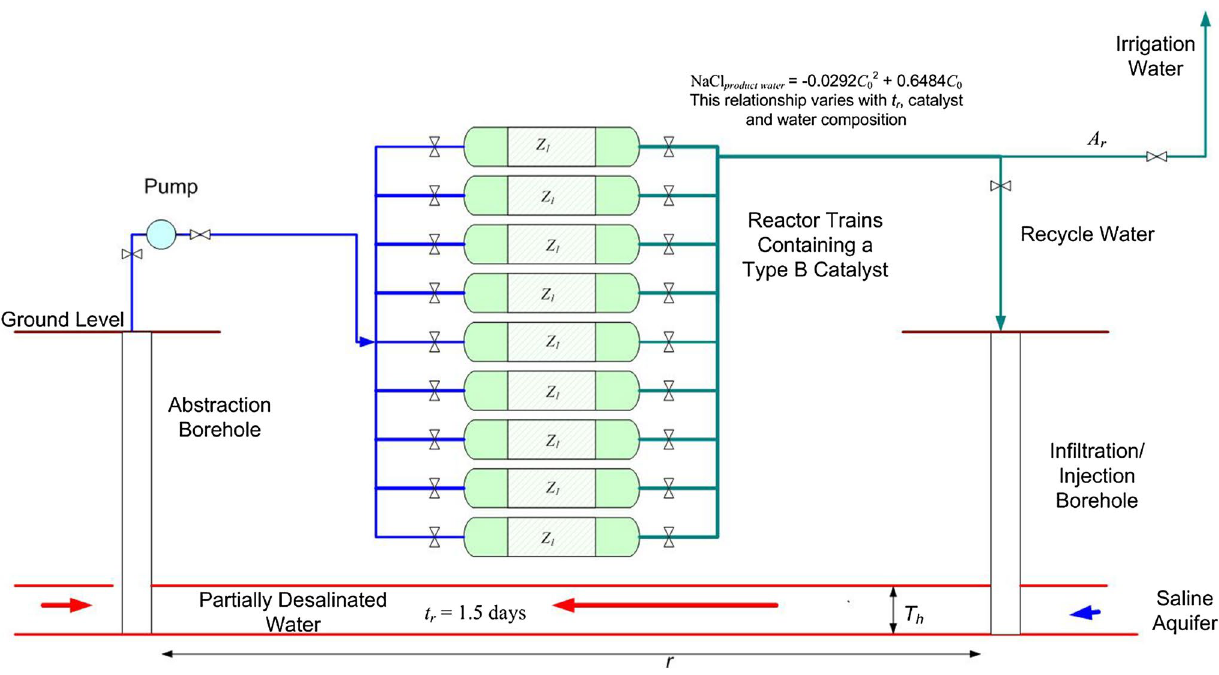
Fig. 14 Process flow diagram for the partial desalination of an aquifer using a Type B catalyst and surface-based reactors